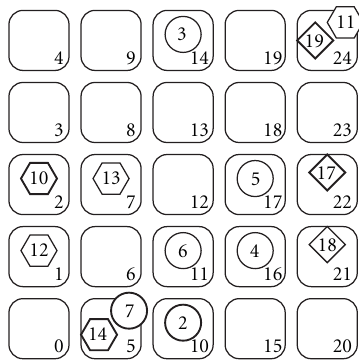
Figure 18: Heuristic placement of task graph from Figure 10 on a 5 × 5 array.